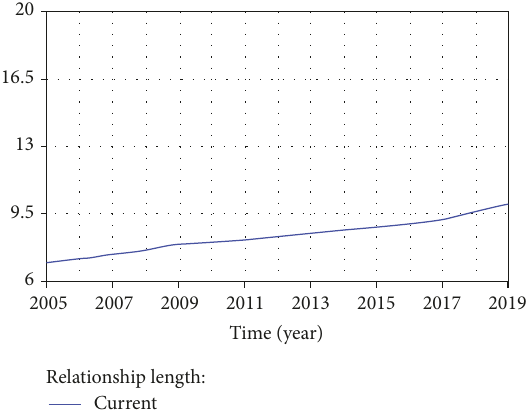
Figure 10: Trends for amount of transactional psychological con- tract implemented (ATPCI).